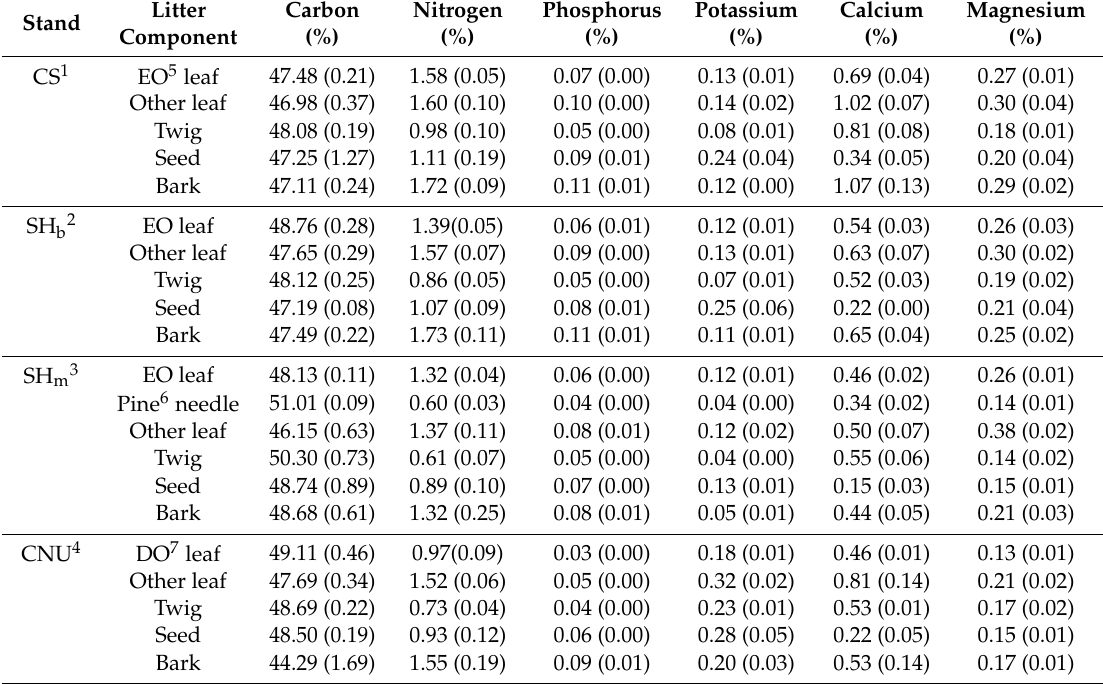
Table 3. Carbon and nutrient (nitrogen, phosphorus, potassium, calcium, and magnesium) concentrations of each litter component at four stands in Jeju Island (CS, SH b , and SH m ) and Daejeon (CNU) of South